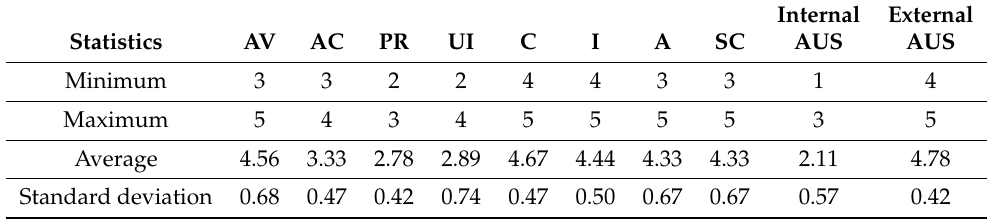
Table 3. Statistics of the criteria ranked by security